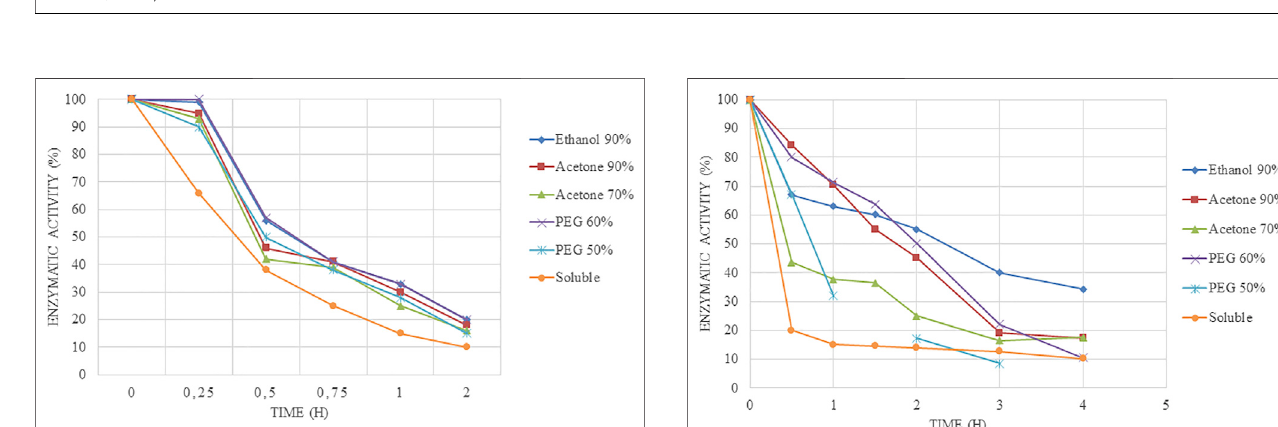
FIGURE 1 | General process for the preparation of cross-linked enzyme aggregates (CLEAs) and the possible variables governing its fi nal performance (Velasco- Lozano, 2020).